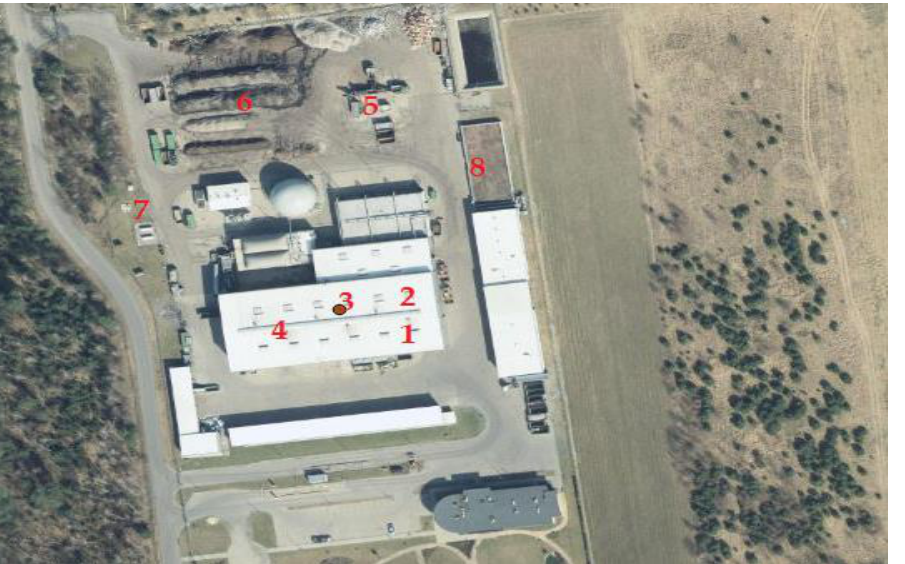
Appl. Sci. 2021 , 11 , x FOR PEER REVIEW Figure 1. Measurement points locations at biogas plant in Biała Podlaska. Figure 1. Measurement points locations at biogas plant in Biała Podlaska.